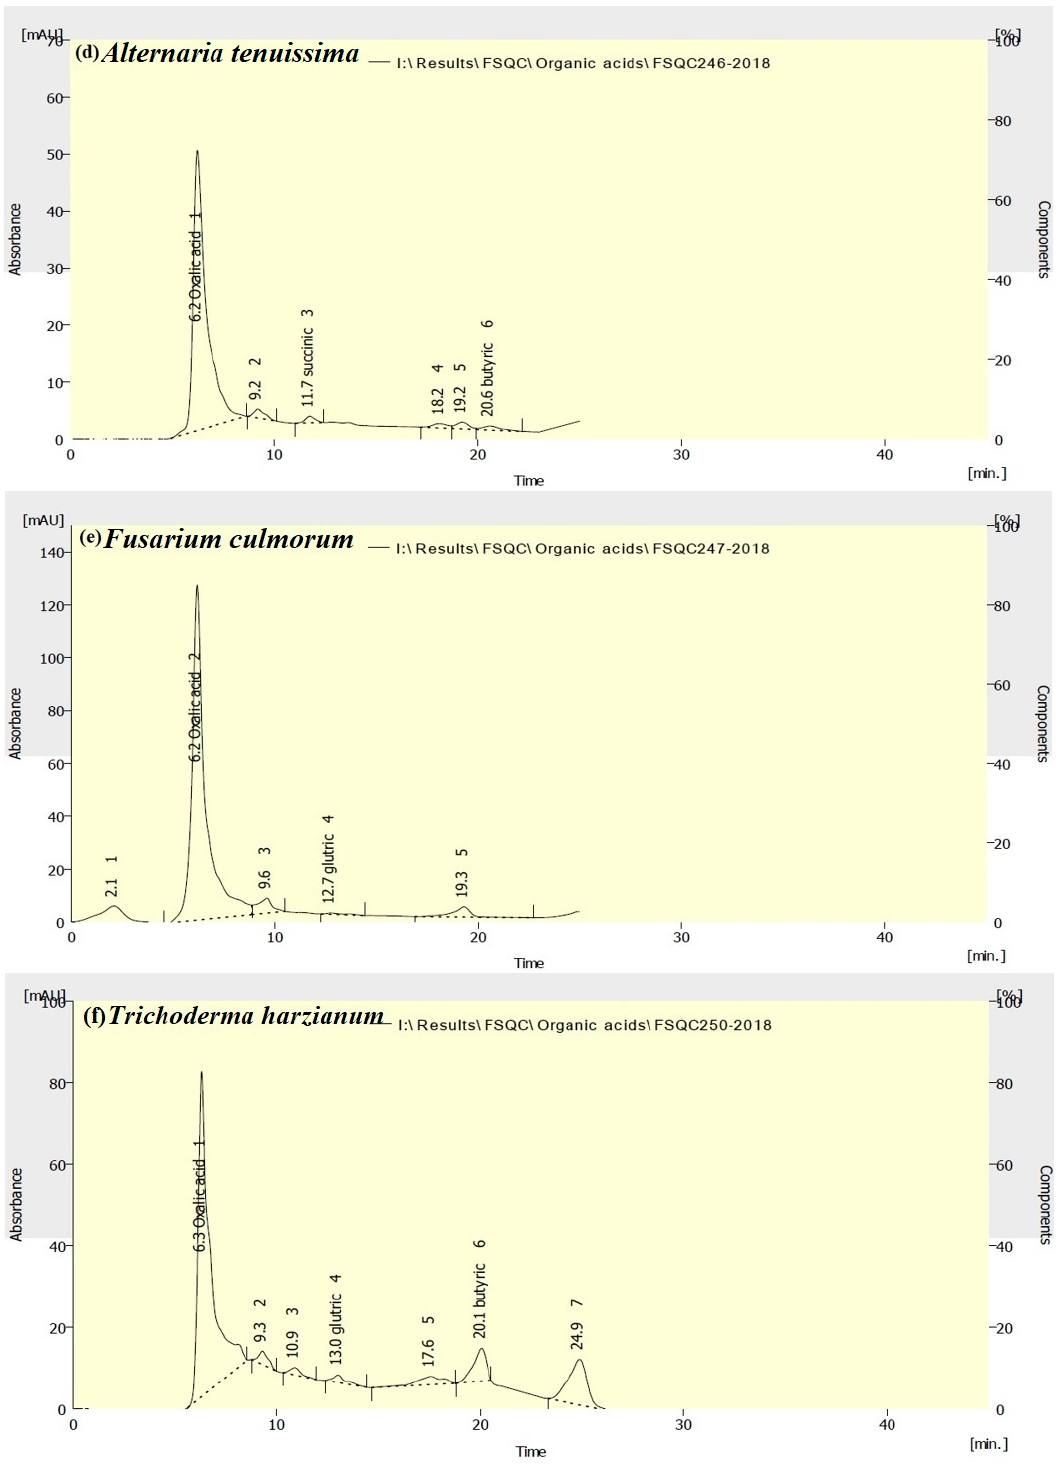
Figure 1. HPLC chromatograms of changes in the organic acids of A. saligna wood inoculated with ( a ) the control, ( b ) A. flavus , ( c ) A. niger , ( d ) A. tenuissima , ( e ) F. culmorum , and ( f ) T. harzianum .